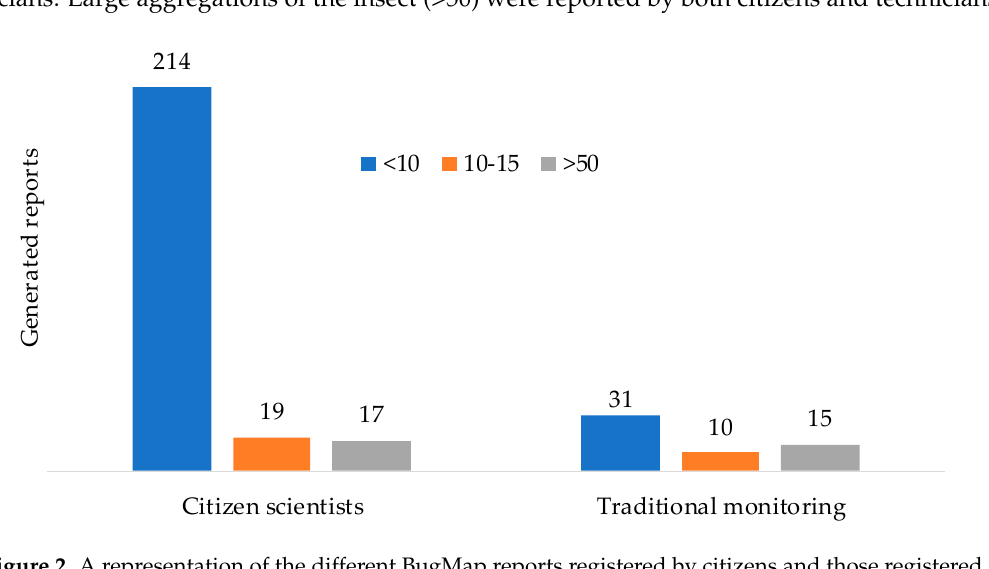
Figure 3. A comparison between traditional monitoring and citizen contribution, taking into account the percentage of reports generated by the two parties from various sighting locations. These results highlight the differences between the two contributing parties, with citizens generating a larger number of reports from more diversified geographical areas. Reports from the general public allowed the identification of a heavily infested nucleus in a public park “Parco Gocciadoro”, outside the city of Trento. This knowledge puts forward the possibility to either treat this zone with selective insecticides, or increase trap density to maximize catches, thus reducing the risk of diffusion to nearby agricultural settings. The real-time tracking of the spread and distribution of insects is usually impeded by technical hitches (lack of time, traps and technicians). Acquainted citizens provided insight on the presence of the insect by performing a more intensive sampling of premises that are difficult to reach by a team of scientists. Thus, the complications aforementioned have been alleviated thanks to the involvement of citizens in the monitoring activity (Figures S2 and S3). These outcomes are in alignment with the proposition of Dickinson et al. [2], who stated that